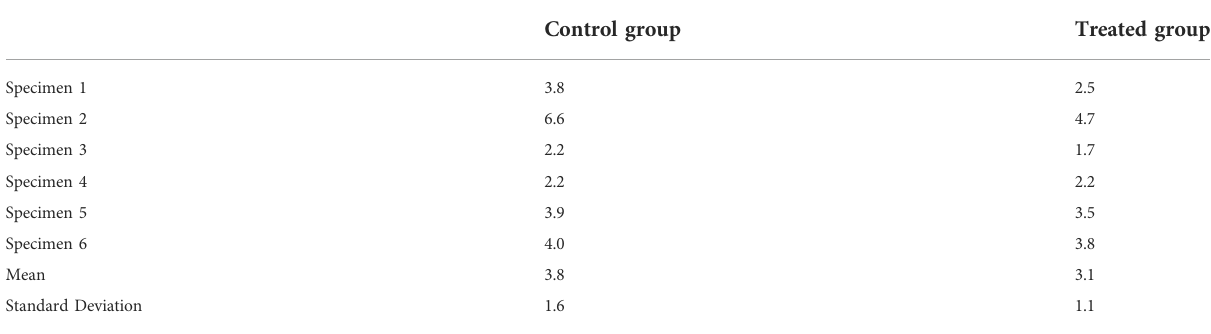
TABLE1Thesulphatedglycosaminoglycan(sGAG)contents(microgramsofsGAGpermilligramligamentdryweight)ofthecranialcruciateligaments (CCLs) in control (proteoglycans were not depleted) and treated (proteoglycans were depleted) groups.